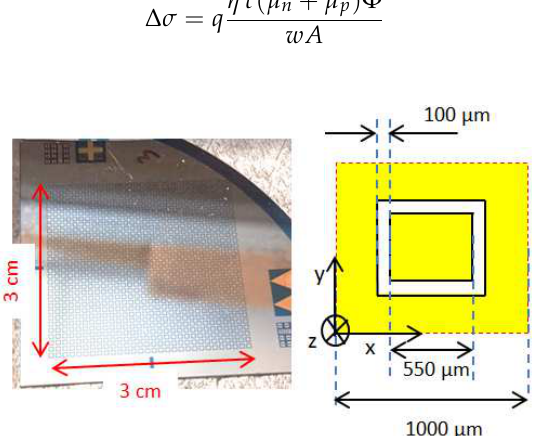
Figure 1. Optical image of frequency-selective surface (FSS) structures on Si substrate and unit cell physical